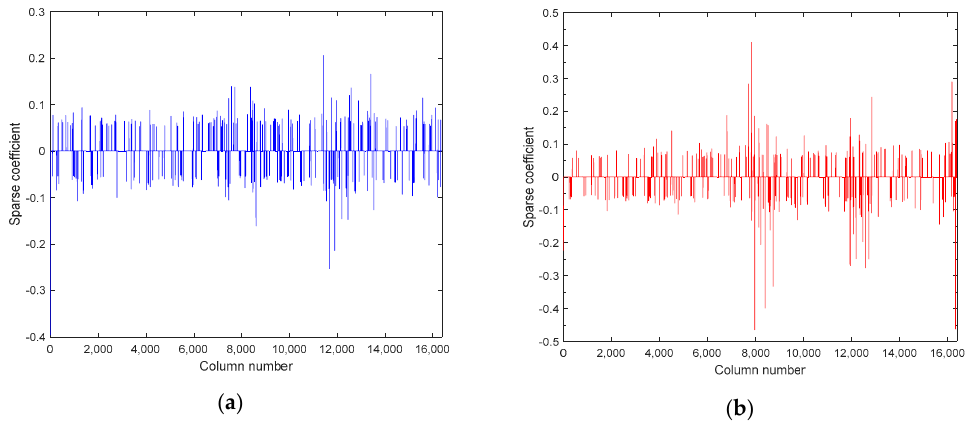
Figure 8. Sparse coefficients of two vibration signals ( a ) Normal current; ( b ) Fault current.